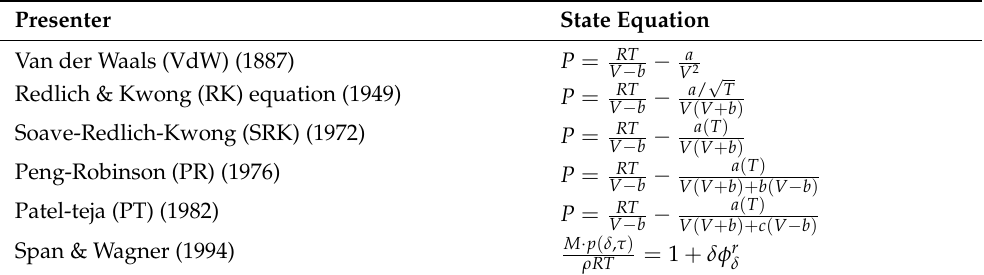
Table 1. Actual gas state